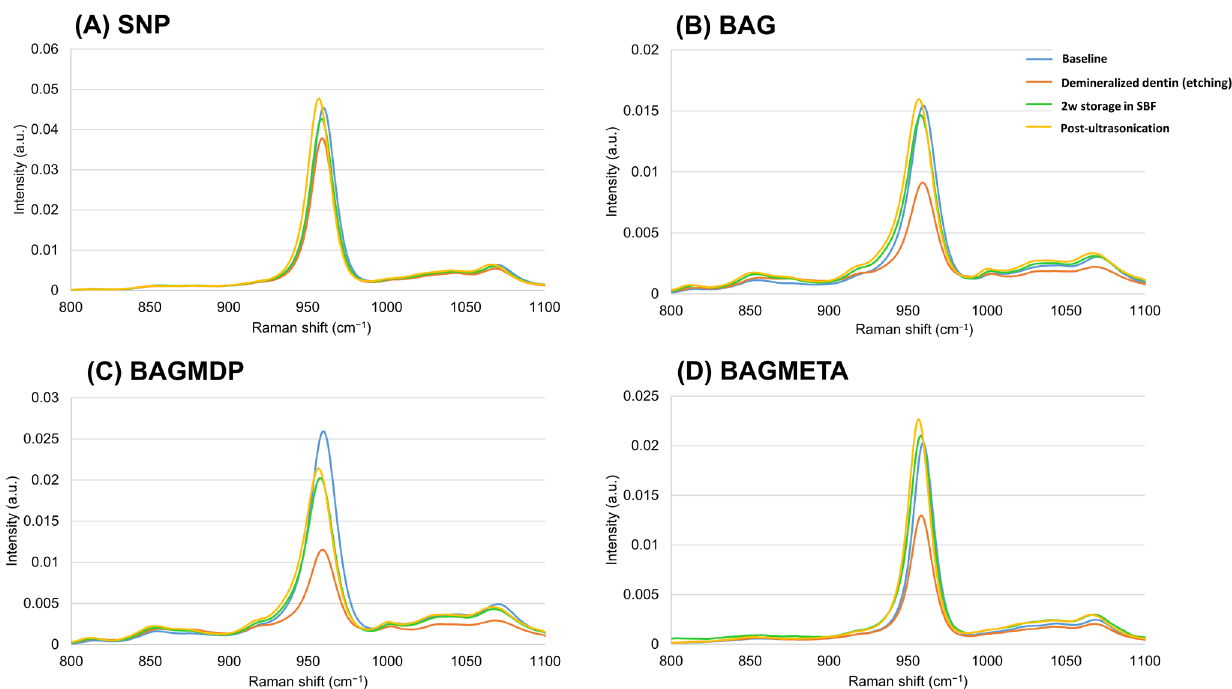
Figure 6. Representative graph of Raman spectra before and after demineralization, 2w storage in SBF of desensitizer-applied dentin, and after ultrasonication.